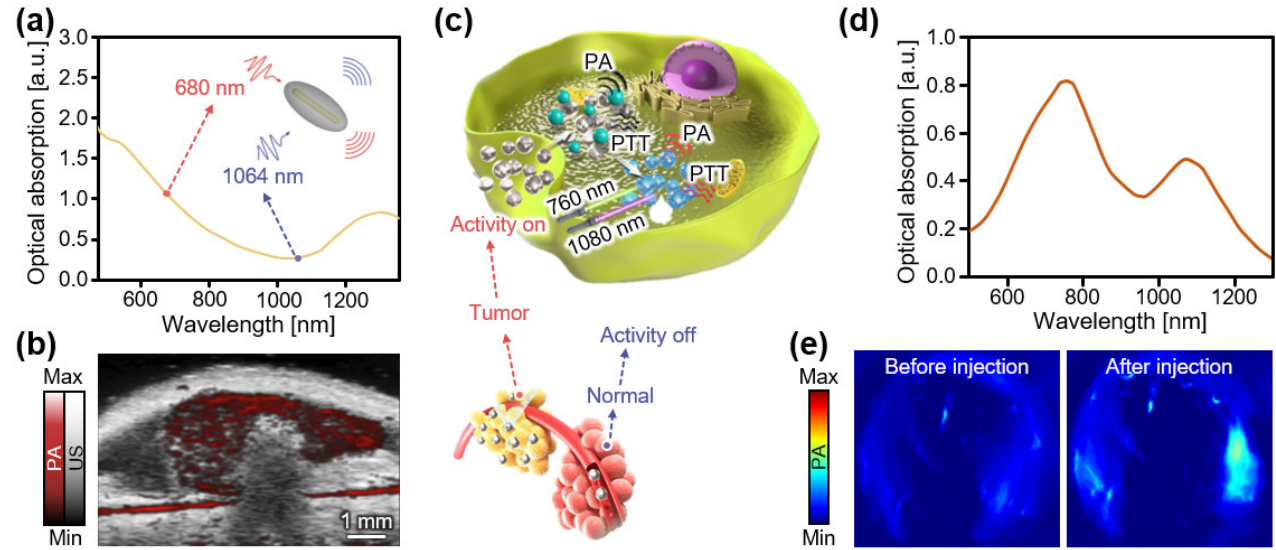
Figure 8. Contrast-enhanced PA images of inorganic nanoparticles in the NIR-II region. ( a ) Optical absorption spectra of AuNR-melanin hybrids. ( b ) Contrast-enhanced PA images of mice in vivo after the subcutaneous injection of nanoparticles. Reprinted with permission from Ref. [111]. 2021, ACS Publications. ( c ) Schematic illustration of PA activation of the MoO 3 nanoparticles in the tumor. ( d ) Optical absorption spectrum of the MoO 3 nanoparticles. ( e ) Contrast-enhanced PA images of tumors in mice before and after injection of the MoO 3 nanoparticles. PA, photoacoustic; US, ultrasound; NIR, near-infrared; PTT, photothermal therapy; MoO 3 , molybdenum oxide. Reprinted with permission from Ref. [114]. 2021, ACS